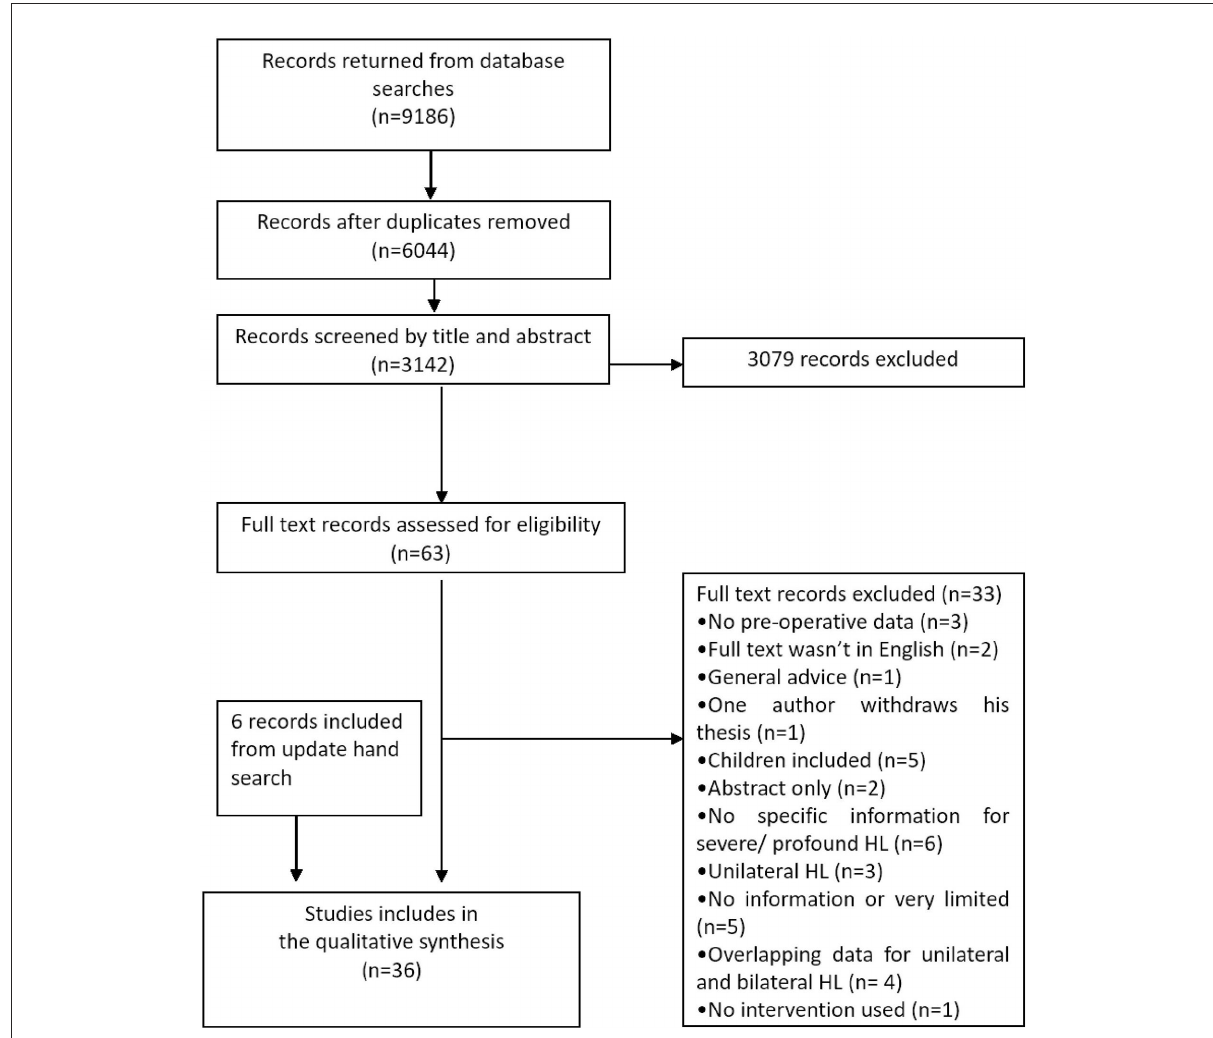
FIGURE1 Flowchart showed the process of extracting, screening and analyzing the